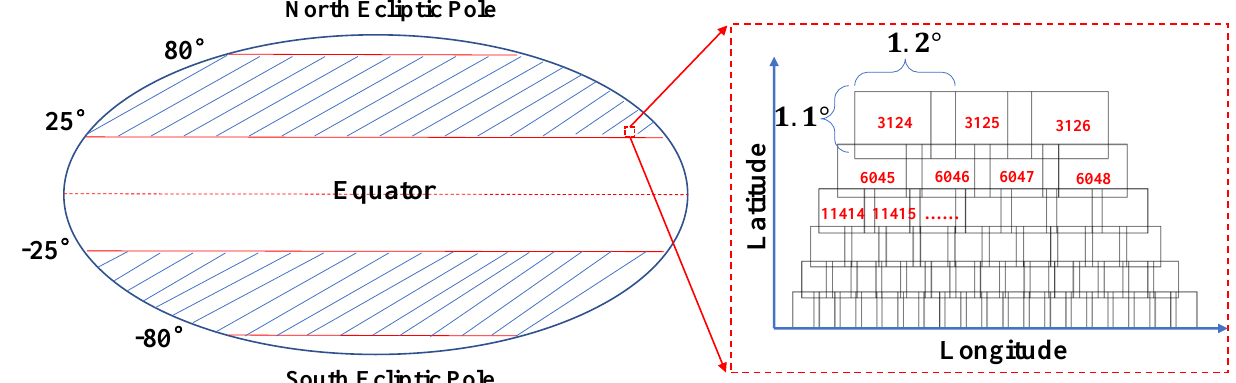
Figure 3. Diagram of sky zone division. The diagram on the left shows the sky zone division range, [ − 80 ◦ , − 25 ◦ ] , and [ 25 ◦ ,80 ◦ ] . On the right side, the dimensions of each small sky zone are shown, as well as the numbering schematic of each sky zone, which is divided into N = 17,712 small sky zones. Ecliptic system of coordinates is used in this paper.